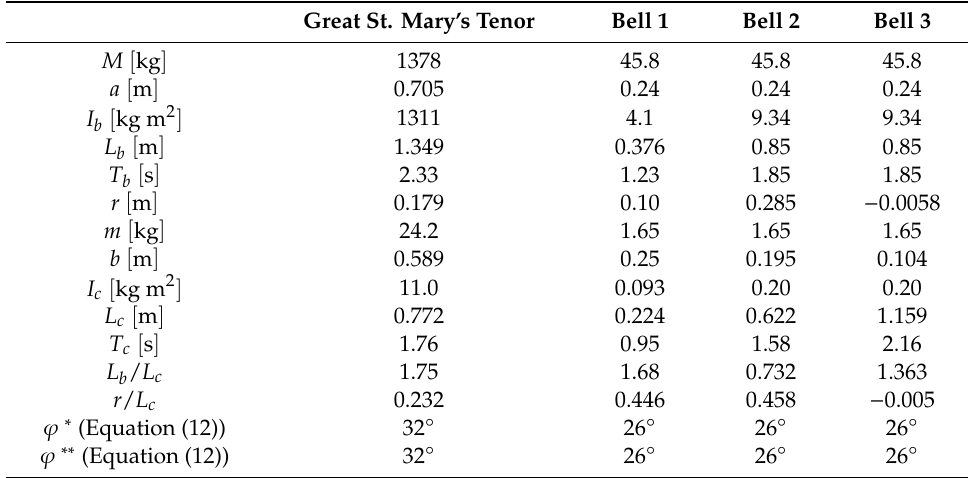
Table 1. Bell and clapper properties (after [18]) of the bells considered in validation.